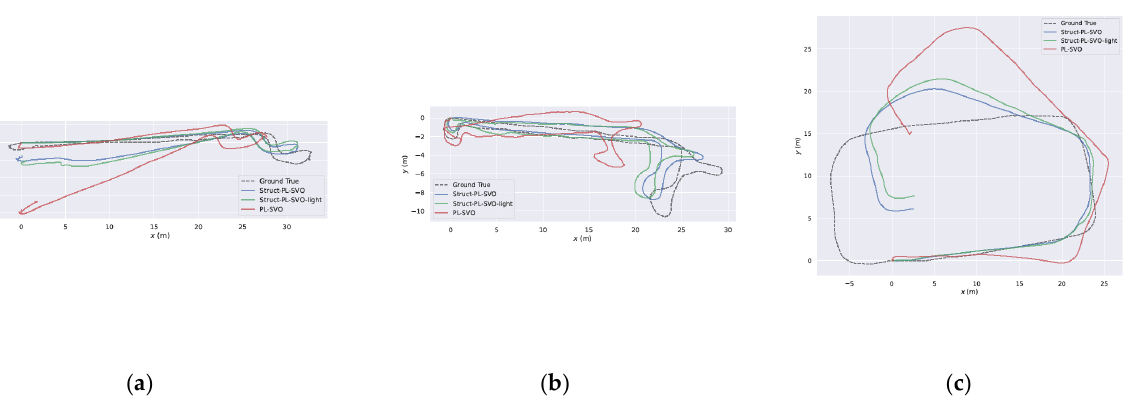
Table 6. Relative RMSE errors in the ceiling dataset.